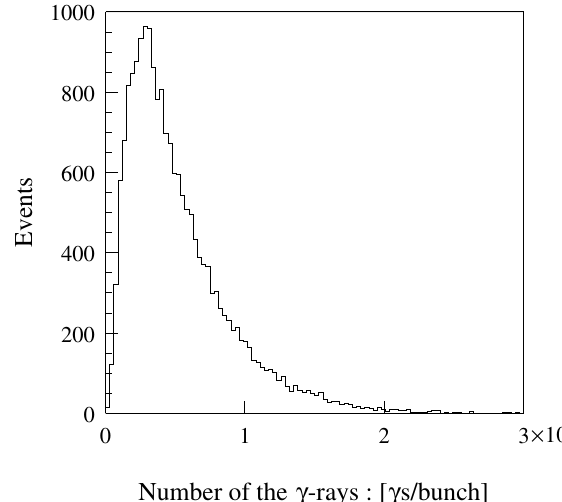
FIG. 21. Number of the generated (cid:1) rays calculated by the numerical model.